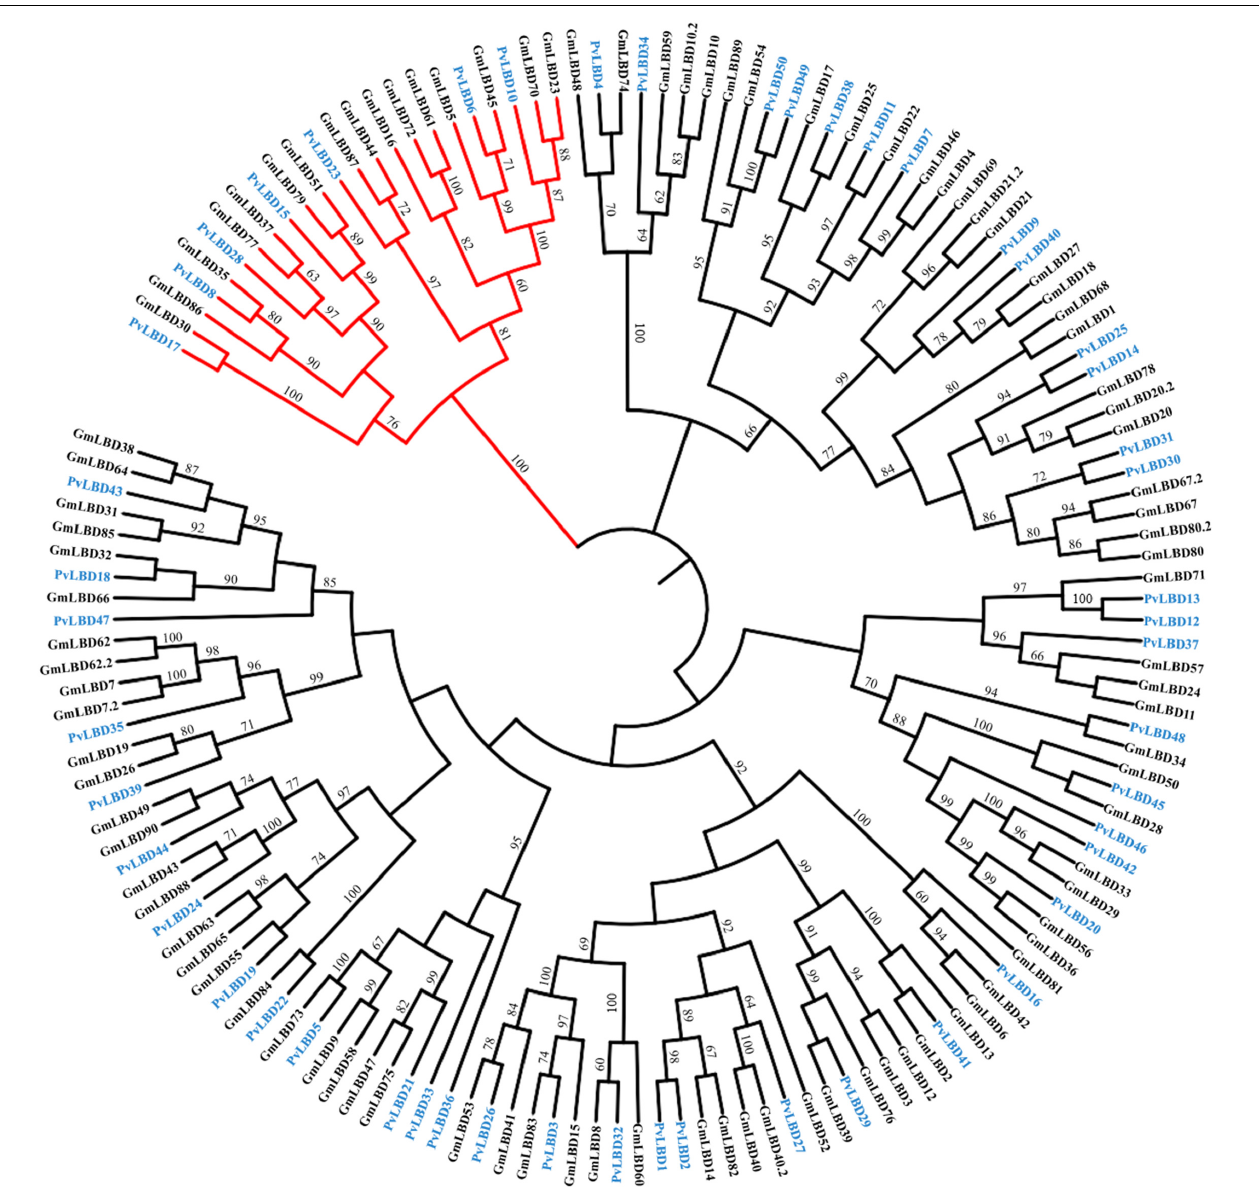
FIGURE 2 | Phylogenetic analysis of LBD proteins in soybean and common bean. The phylogenetic tree was constructed according to the same method. Class II LBD family members were shown in red branches. GmLBDs and PvLBDs were marked with green and blue protein names, respectively. Bootstrap values of more than 60 are represented on each